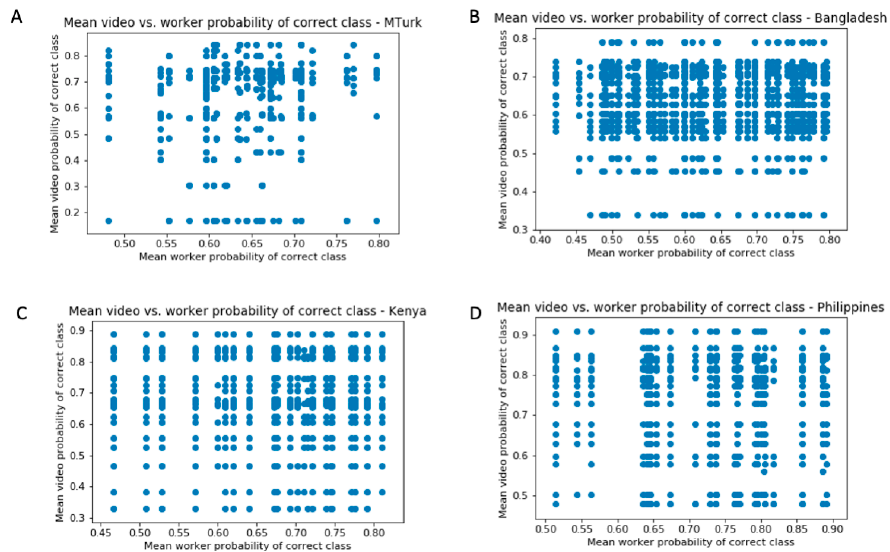
Figure 4. Mean classifier confidence per video vs. per worker for ( A ) MTurk workers, ( B ) Bangladesh Microworkers, ( C ) Kenya Microworkers, and ( D ) Philippines Microworkers for videos with at least 10 ratings and workers who provided at least ten ratings. Each vertical line of points contains the di ffi culty levels of videos rated for one worker, visually demonstrating that workers received similar distributions of video di ffi culties to rate despite displaying large variation in